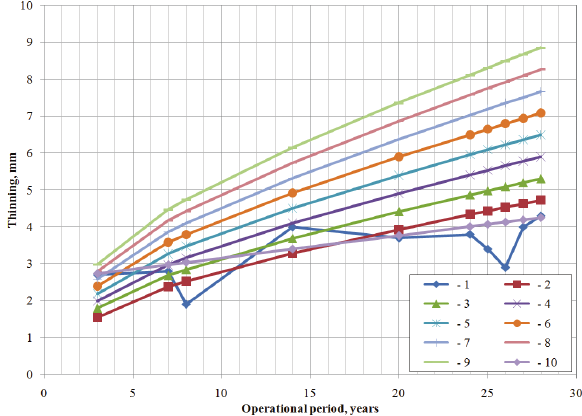
Figure 7. Correlation of thinning values obtained in different ways: 1 – control; 2 – Ке = 0.16; 3 – Ке = 0.18; 4 – Ке = 0.20; 5 – Ке = 0.22; 6 – Ке = 0.24; 7 – Ке = 0.26; 8 – Ке = 0.28; 9 – Ке = 0.30; 10 – screened values.